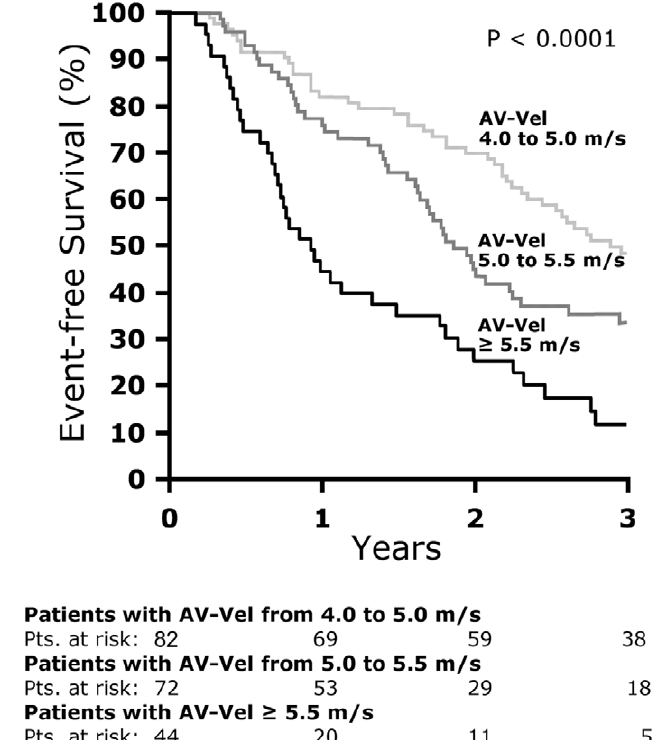
Figure. 1 Event free survival rate for patients with differing peak aortic jet velocity (AV-Vel) (from Rosenhek et al. reference